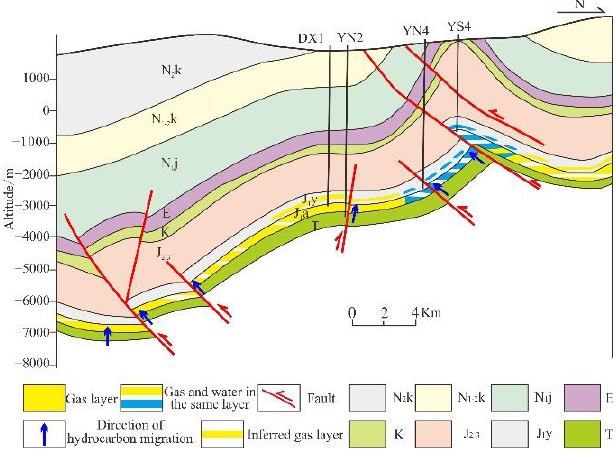
Figure 14. Comprehensive reservoir formation pattern in Dibei area (modified from Xiongqi Pang, 2019 [16] and Song Guo, 2018 [22]).